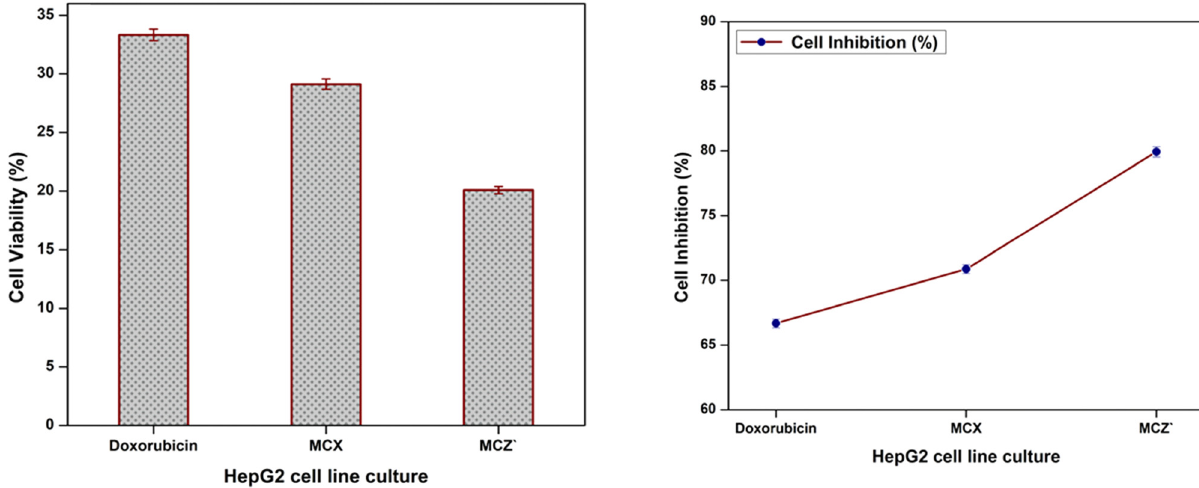
Figure 12: Cell viability and cell inhibition percentage relative to the untreated control ( mean ± SE )